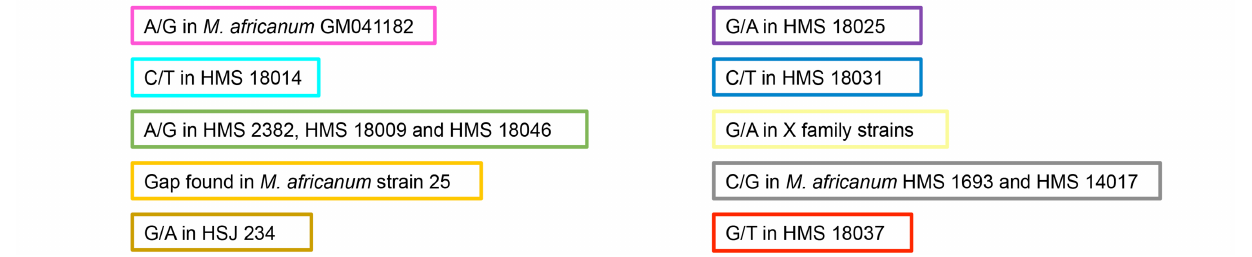
FIGURE 2 | Sequence of IS 6110 , highlighting in different coloured squares the points, the nucleotide changes, and the different strains where the 10 mutations were found. orfA is written in yellow, orfB is in red, and the overlapping region is in green. The black letters at the ends represent the inverted